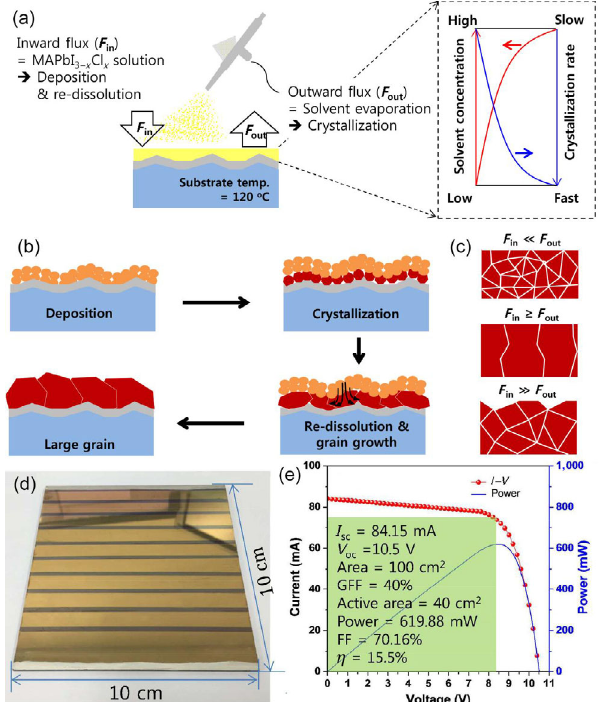
Figure 5 (a) Schematic illustration for the spray coating mechanism. (b) Crystalline grain growth of the perovskite film, and (c) balance between F in and F out . (d) Photograph images of the 10 cm × 10 cm module. (e) Photovoltaic properties. Reproduced with permission from Ref. [52], © Royal Society of Chemistry 2016.